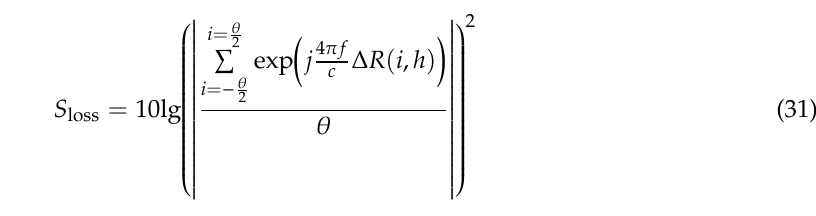
Figure 12. h – ρ curve. It can be seen in Figure 12 that as h increases, ρ gradually decreases. When h = 100 m, ρ decreases to 0.89. We use the 3 × 3 filter window for phase filtering, thus NL = 9. According to Equation (32) and Figure 12, the h – σ ps curve can be acquired, as shown in Figure 13.